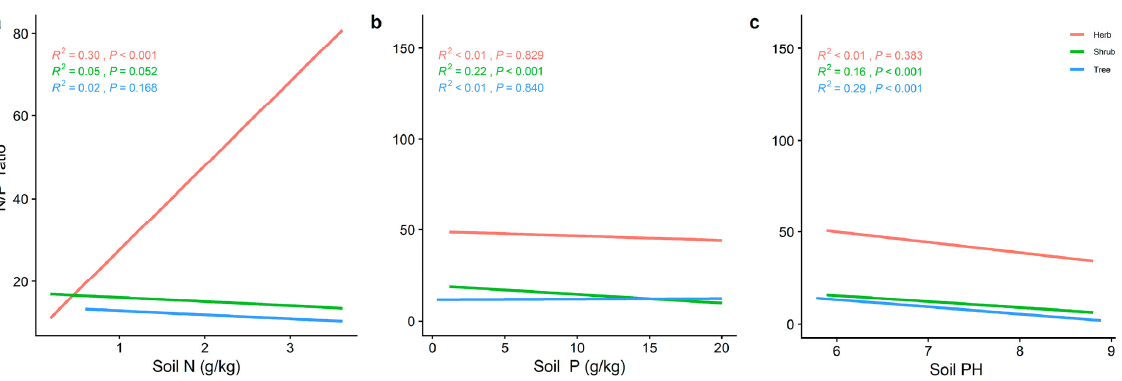
Figure 8. The general linear analysis of soil factors with different life forms of N/P. ( a ) General linear relationship between the soil N and N/P of plants in the trees, shrubs, and herbs ( b ) General linear relationship between the soil P and N/P of plants in the trees, shrubs, and herbs. ( c ) General linear relationship between the soil pH and N/P of plants in the trees, shrubs, and herbs. The red line represents the tree level, the green line is the shrub level, and the blue line is the herb level. R 2 represents how well the model fits the variables studied and the P − value represents the level of significance. 2.4. Climatic and Soil Factors Dominate Changes in the Functional Traits of Different Commu- nities We analyzed the effects of environmental factors on the leaf LN, LP, and N/P at dif- ferent life forms based on a generalized additive model with non − metric multidimen- sional scaling (NMDS) ranking. Overall, the leaf N/P showed strong environmental plas- ticity, and environmental factors generally explained the spatial variation in leaf N/P more than LN and LP at different life forms (Figures 9 – 11). Climate factors played a greater role than the soil nutrient factors in shaping the spatial variation in the leaf LN (Figure 9d − f; de = 42.2%, 41%, 22.8%) and LP (Figure 10d − f; de = 17.2%, 17.1%, 50.6%).